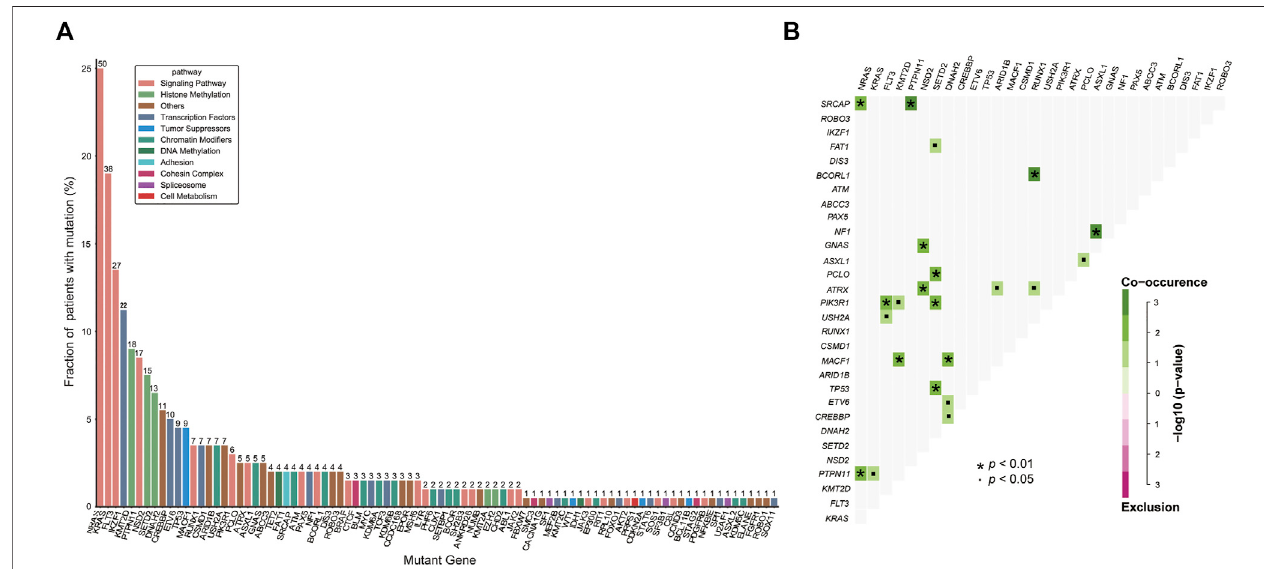
FIGURE 2 | Genetic analyses in the whole cohort. (A) Histogram shows the frequency of gene mutations detected in the whole cohort according to the different functionalgroupsassignedtoeachgene. (B) Diagramshowspairwisegenemutationcorrelationsonthebasisofthemutatedgenesdetectedin ≥ 2%patients.Theodds ratio of the correlation is coded by different colors, and the signi fi cance level is marked by the symbol in each fi eld.